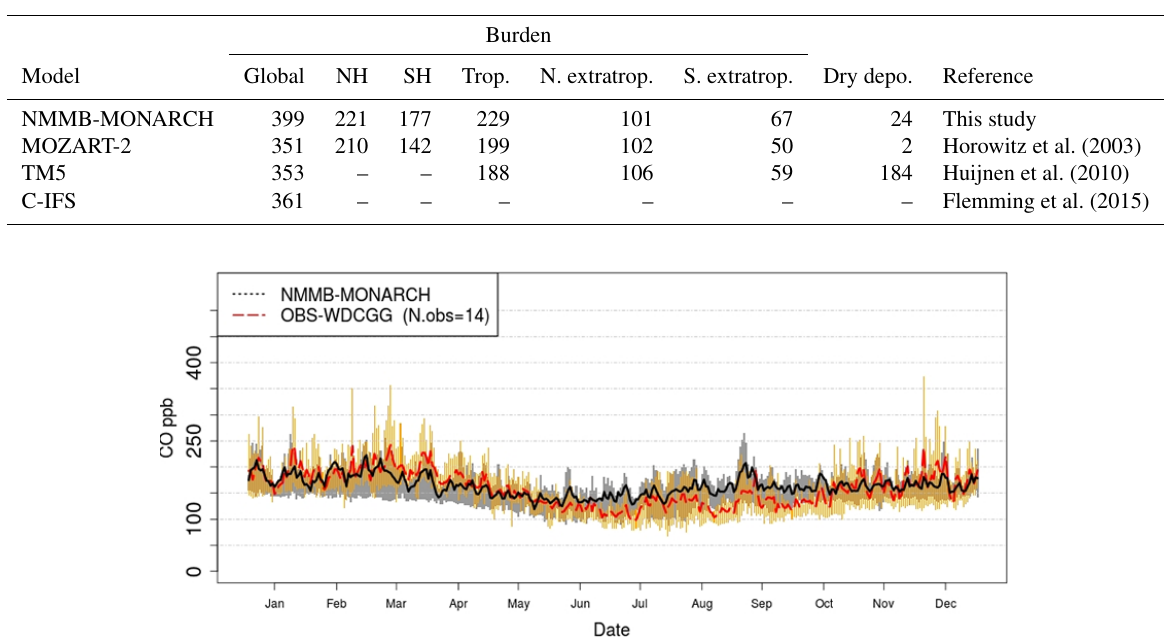
Table 6. Annual mean burden of tropospheric CO (TgCO) in the NMMB-MONARCH, MOZART-2, TM5 and C-IFS global models.